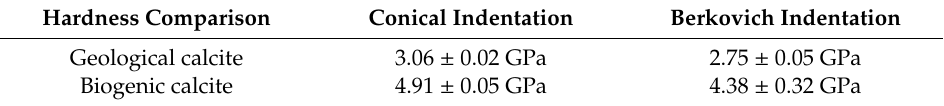
Table 2. Comparison of hardness for Conical and Berkovich indentation (depth: 100 to 250 nm). Hardness